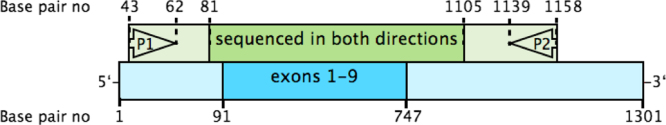
Hprt primer positions, amplified and sequenced sequences of Hprt cDNA. Primers (P1 and P2) were positioned in the 3′- and 5′-untranslated region (light blue) of Hprt cDNA (reference cDNA sequence: GenBank: J00060.1; http://www.ncbi.nlm.nih.gov/nuccore/J00060.1) 29 base pairs distant from exon 1 (P1) and 392 base pairs distant from exon 9 (P2). The first few base pairs cannot be analyzed reliably by Sanger sequencing (light green) but base pairs 81 and higher as well as 1105 and lower were analyzable in every sequencing reaction (green). (For interpretation of the references to color in this figure legend, the reader is referred to the web version of this article.)